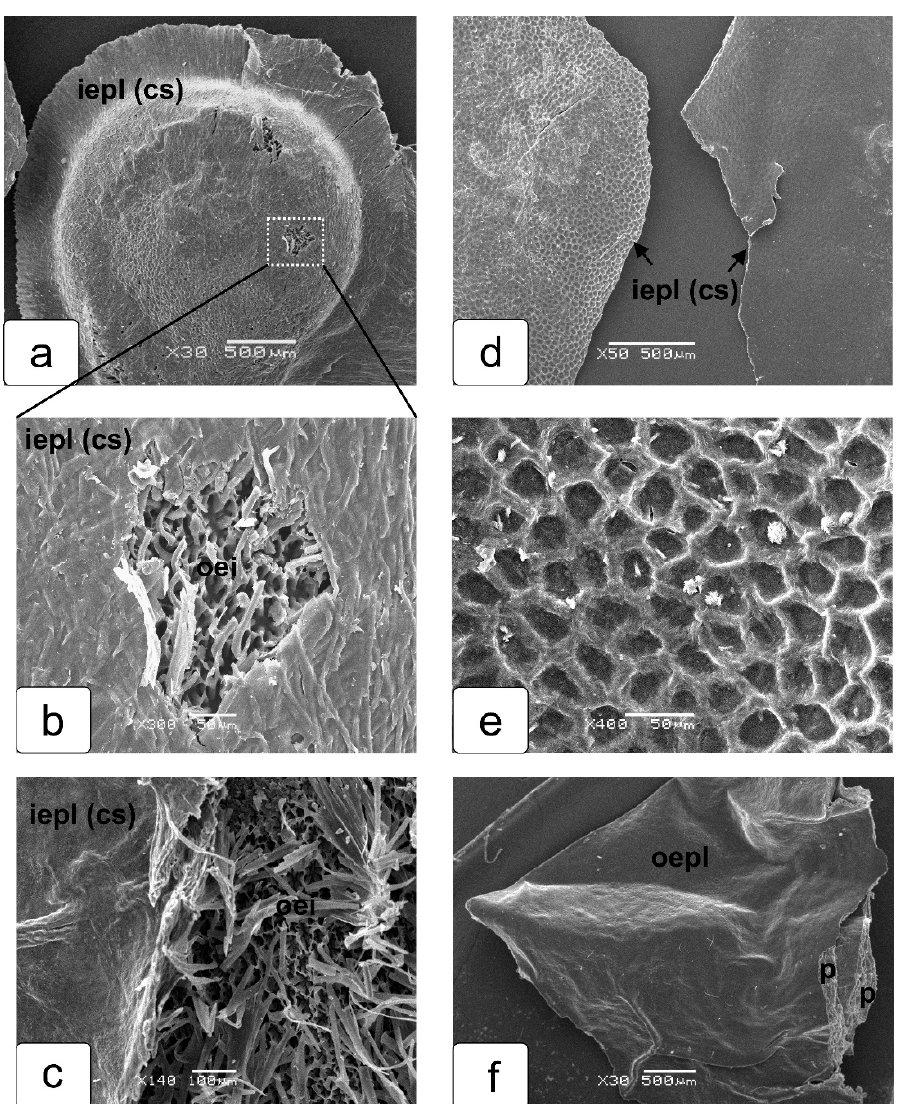
Figure 7. Details of the structure of the shell of the placenta seed capsule (formed by epidermal cells of the protruding placental tissue) of the tomato fruit, revealed from scanning electron microscopy. The capsule shell was removed from the dried seed together with the cell fragments of seed epidermal cells ( a – c ). The inner side (adjacent to the seed) of this shell ( d , e ) and its outer side ( e , f ) are shown. On the inner side, the end walls of the outer layer cells of the seed coat were imprinted (remained) ( e ). The outer side of the outer epidermis of the placental protrusion looks elastic and quite strong and retains desiccated fragments of the placental protrusion ( f